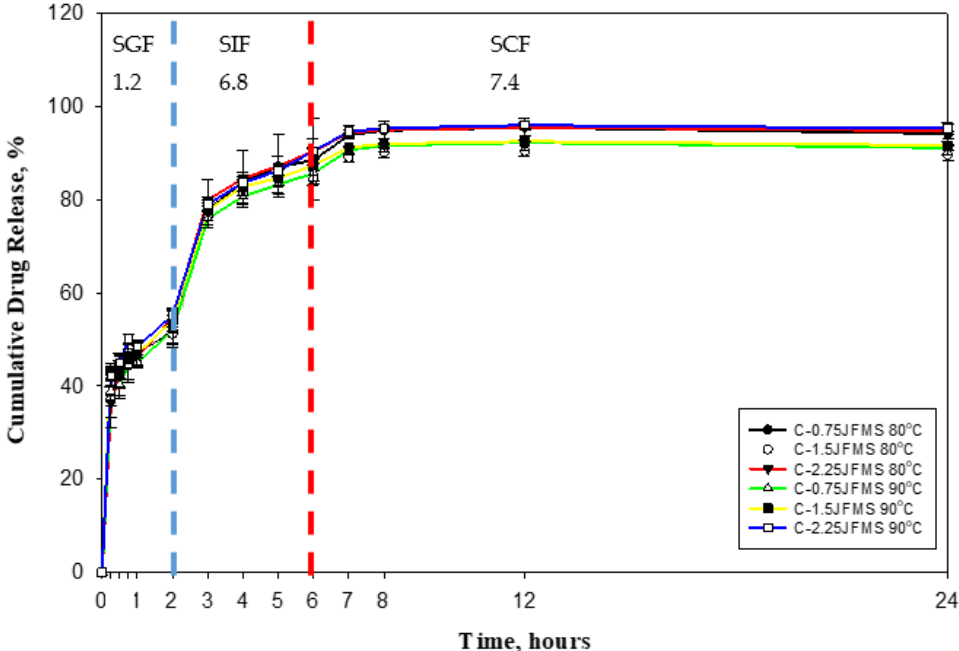
Figure 8. The cumulative drug release profile.